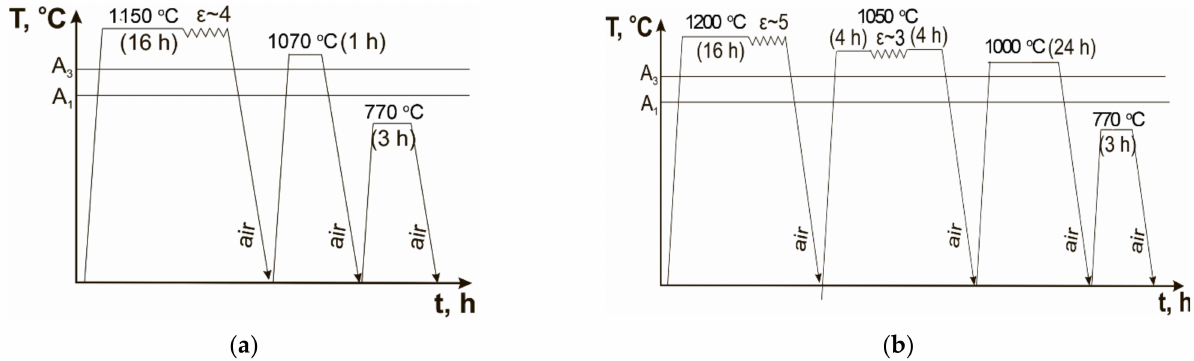
Figure 1. ( a ) Schematic illustration of the CHT consisting of homogenization annealing at 1150 ◦ C for 16 h with following forging at 1150 ◦ C with true strain of ~4, air cooling, then normalizing at 1070 ◦ C for 1 h, air cooling, and final tempering at 770 ◦ C for 3 h, air cooling; ( b ) schema of the TMP consisting of homogenization annealing at 1200 ◦ C for 16 h with following forging at 1200 ◦ C with a true strain of ~5, air cooling, then annealing at 1050 ◦ C for 4 h with following forging at 1050 ◦ C with a true strain of ~3 and annealing at 1050 ◦ C for 4 h, air cooling; next, normalizing at 1000 ◦ C for 24 h, air cooling, and final tempering at 770 ◦ C for 3 h, air